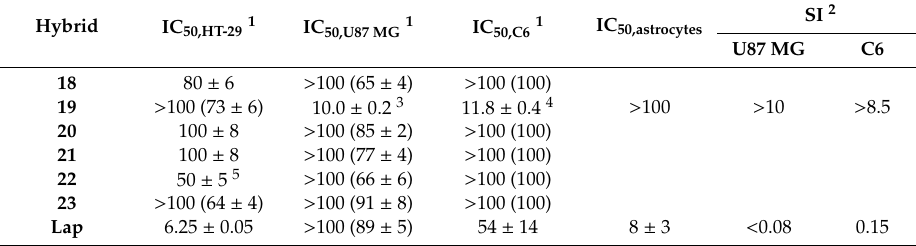
1 Values in parenthesis correspond to the percentage of cell survival at 100 µ M. 2 Selectivity indexes (SI) = IC 50,astrocytes / IC 50,indicatedcells . 3 IC1 (dose necessary to inhibit 1% of growth cells) = 9.2 ± 0.8 µ M, IC 20 (dose necessary to inhibit 20% of growth cells) = 9.7 ± 0.1 µ M, IC 80 (dose necessary to inhibit 80% of growth cells) = 11.0 ± 0.1 µ